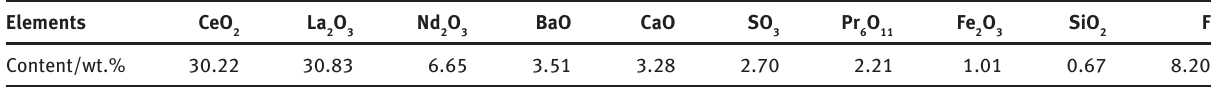
Table 1: Chemical compositions of bastnaesite concentrate. Elements Content/wt.%